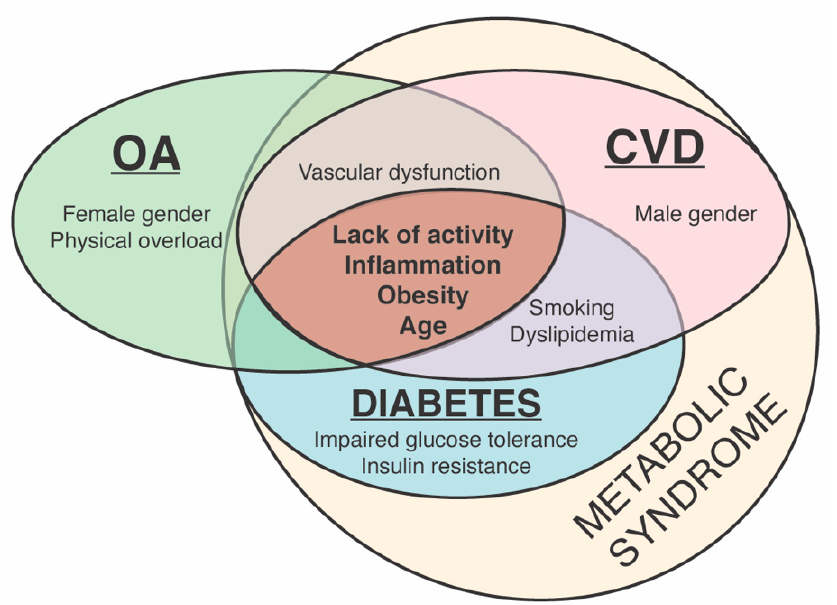
Figure 1. Common and distinct risk factors for osteoarthritis (OA), cardiovascular diseases (CVD) and diabetes and their relation to metabolic